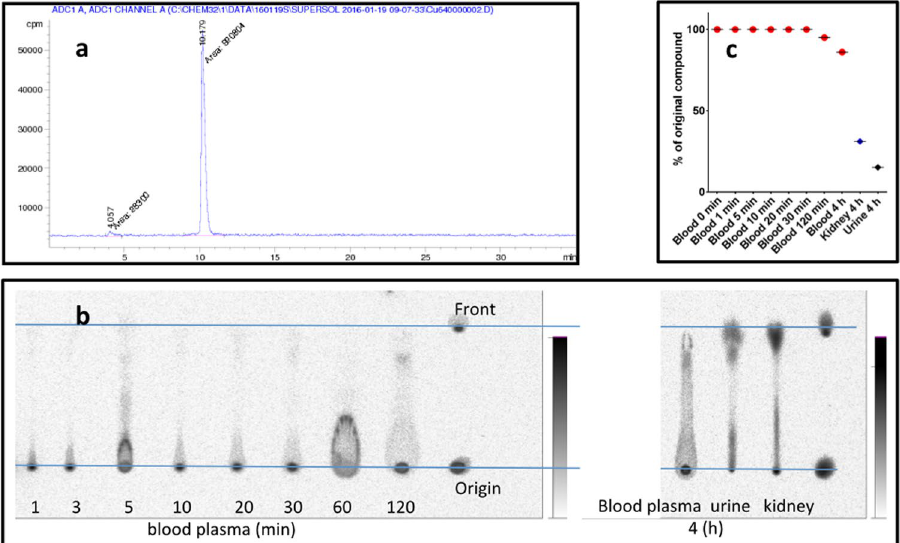
Figure 8. Metabolite analysis. ( a ) Radio-HPLC chromatogram of the [ 64 Cu]Cu-NOTA-HsTX1[R14A], ( b ) Radioluminogram of 64 Cu in a TLC analysis of rat arterial blood plasma samples of 1, 3, 5, 10, 20, 30, 120 min and 4 h, urine and kidney extract samples at 4 h p.i.; ( c ) Radioactive metabolite fraction in the arterial blood plasma samples, kidney extract and urine expressed as % of original